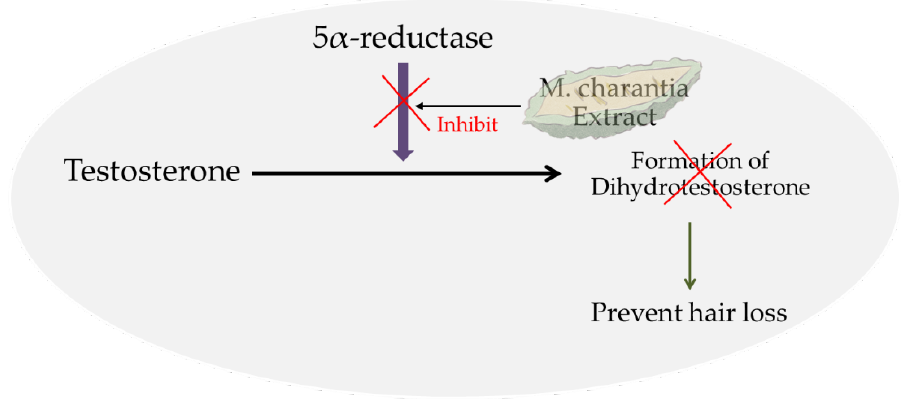
Figure 1. The schematic representation of the hair-loss prevention properties of M. charantia . The phenolic compounds can act as 5aR inhibitors, and the overactivity of 5aR is antioxidant activity, and 5aR inhibitory activity of M. charantia extract and formulate